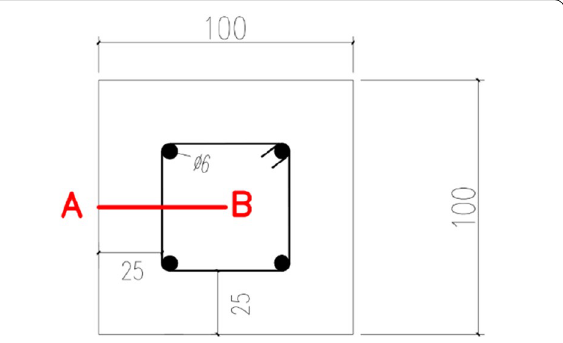
Fig. 8 Reinforced concrete component with a rectangular section (size unit: